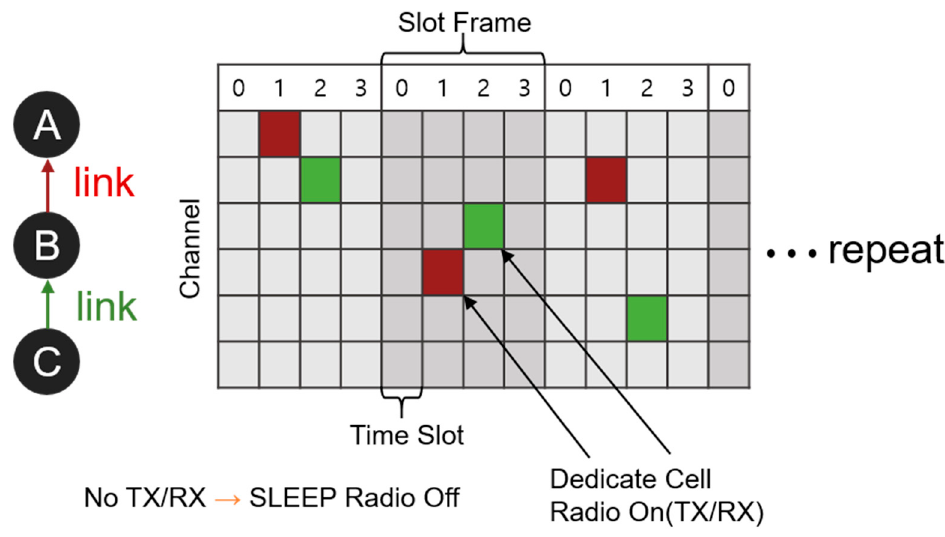
Figure 1. TSCH Figure 1. TSCH Operation.